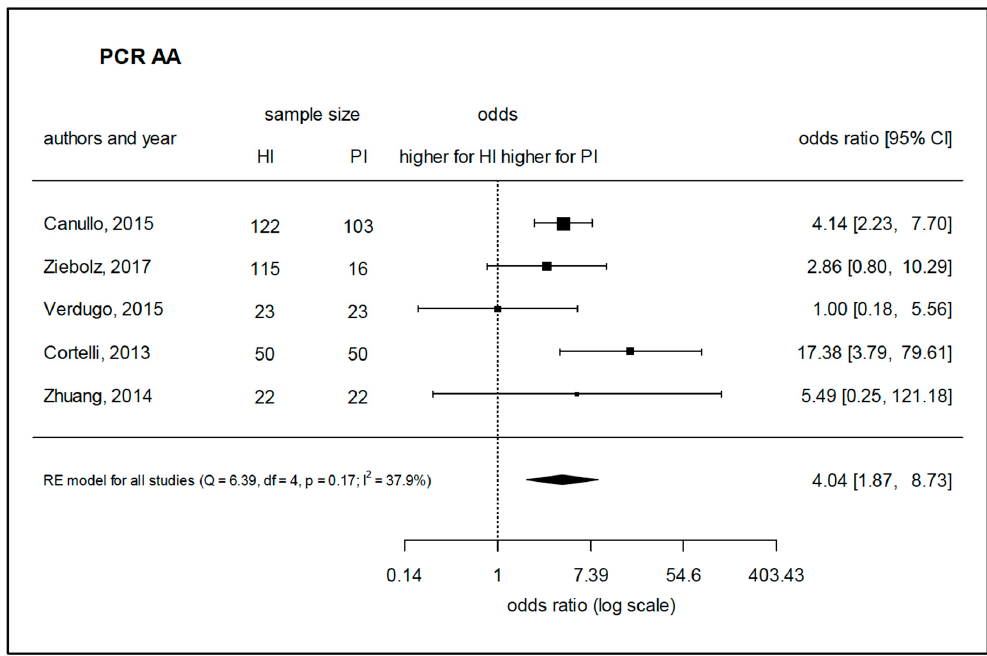
Figure 4. Meta-analysis for the presence of Aggregatibacter actinomycetemcomitans in either healthy sites or peri-implantitis sites (studies performing PCR-based analysis). HI—healthy implants, PI—implants with peri-implantitis, Q—Cochrane’s Q, df—degrees of freedom, p —level of significance, I 2 —proportion of observed variance (heterogeneity).